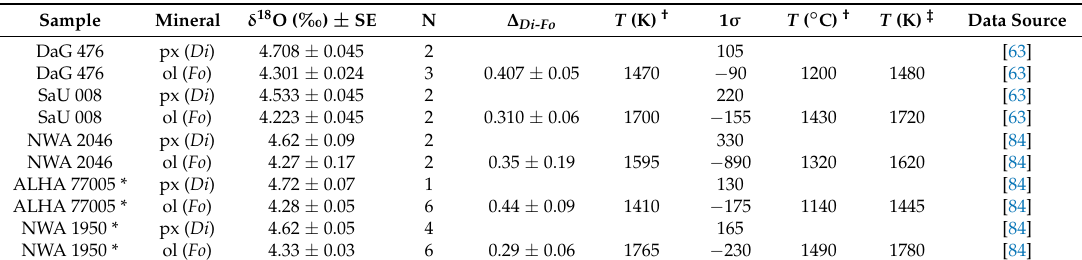
Table 1. Oxygen isotopic compositions of pyroxene and olivine in shergottites. Estimated temperatures are also